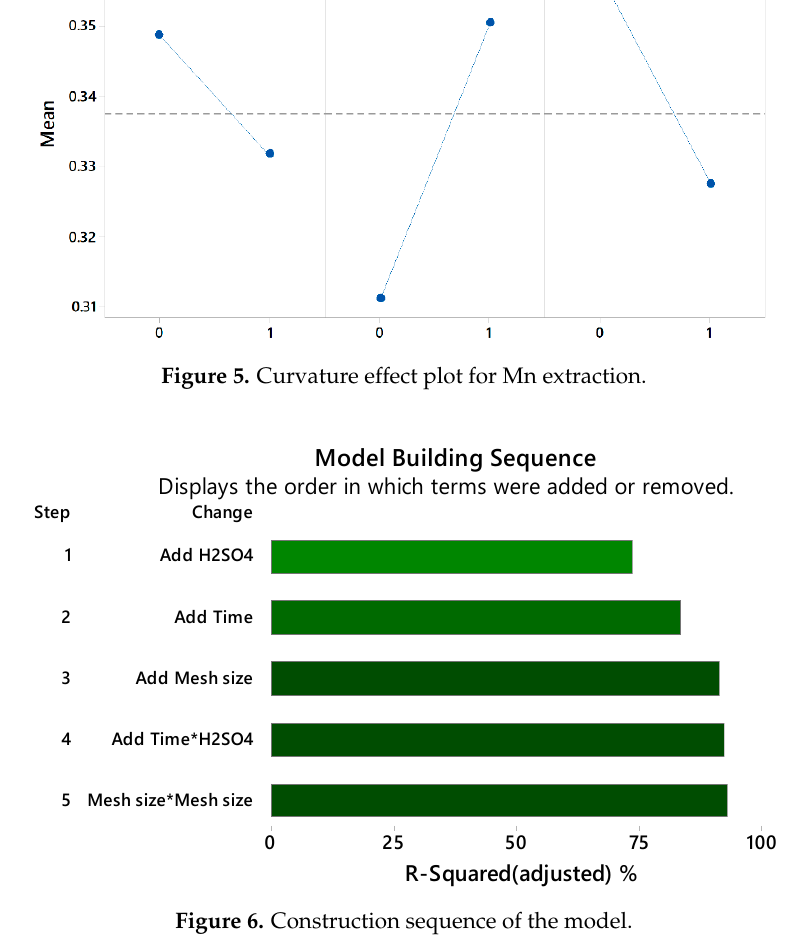
Figure 6. Construction sequence of the model.